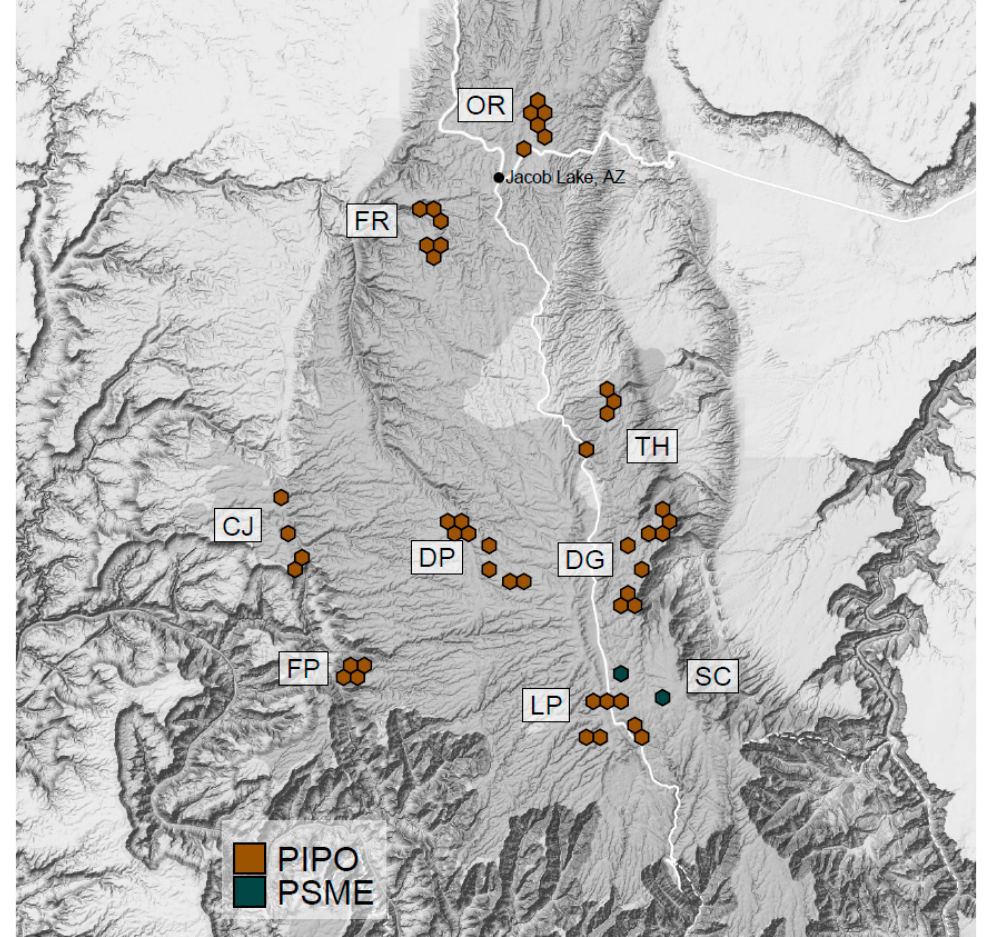
Figure 1. Map of study sites and trees cored on the Kaibab Plateau in northern Arizona. Full study site names and species codes are given in Table 1.